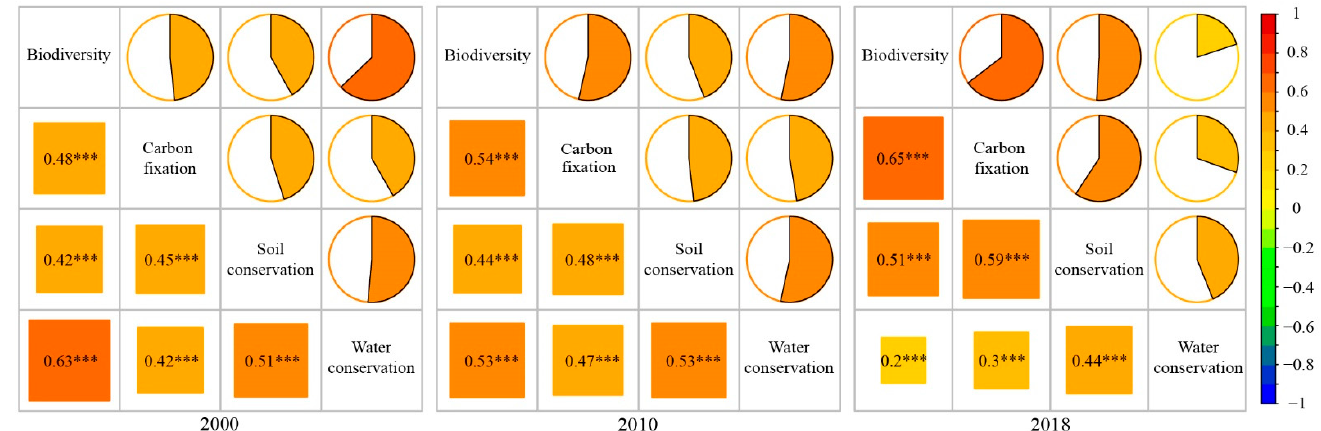
Figure 7. Spearman correlation coefficients between ES pairs. The statistical significance levels were extremely significant (*** p < 0.001).